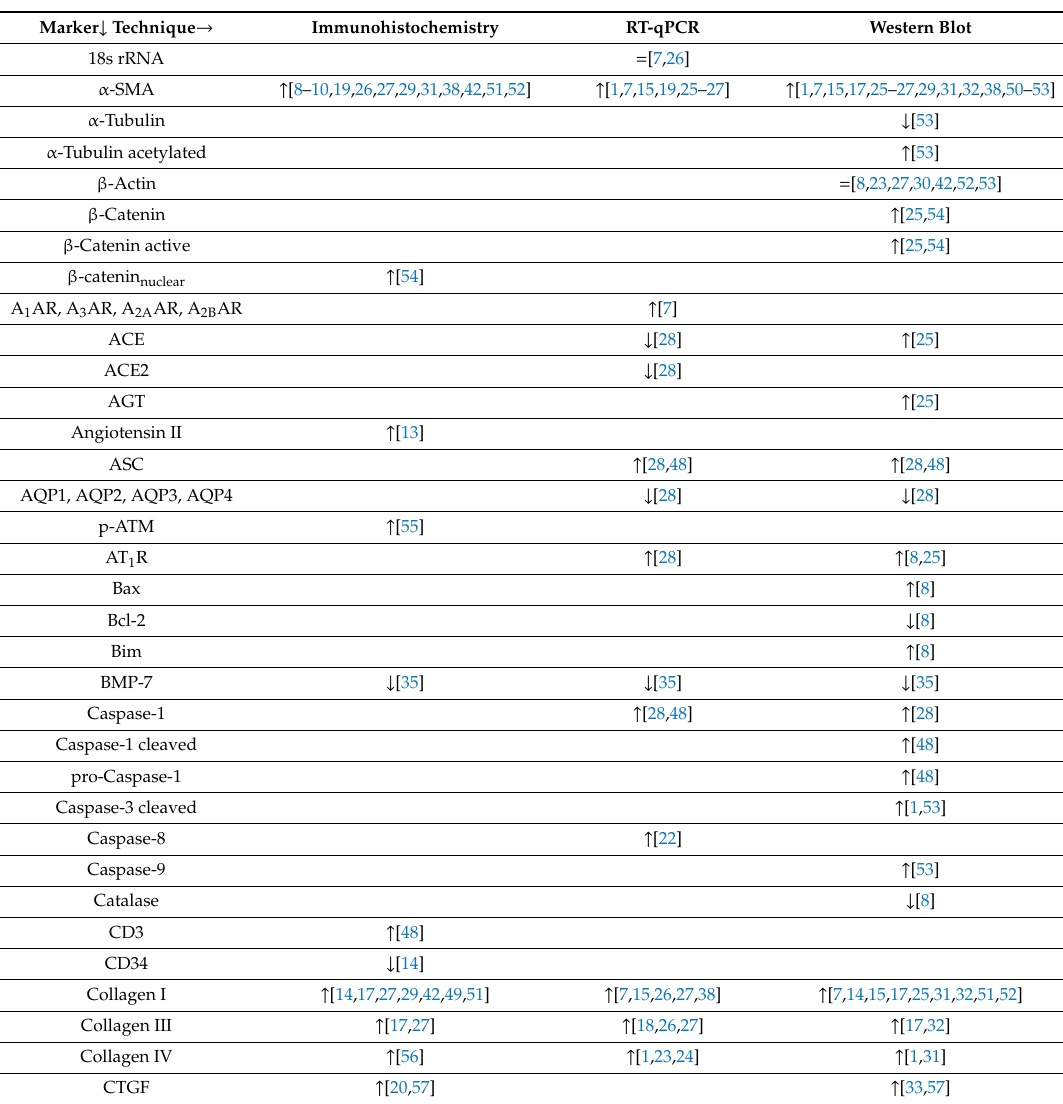
Table 2. Antibodies used to detect proteins by immunohistochemistry or Western Blot or gene expression measured by RT-qPCR. Arrows indicate increase or decrease in levels of UUO-OKs compared to